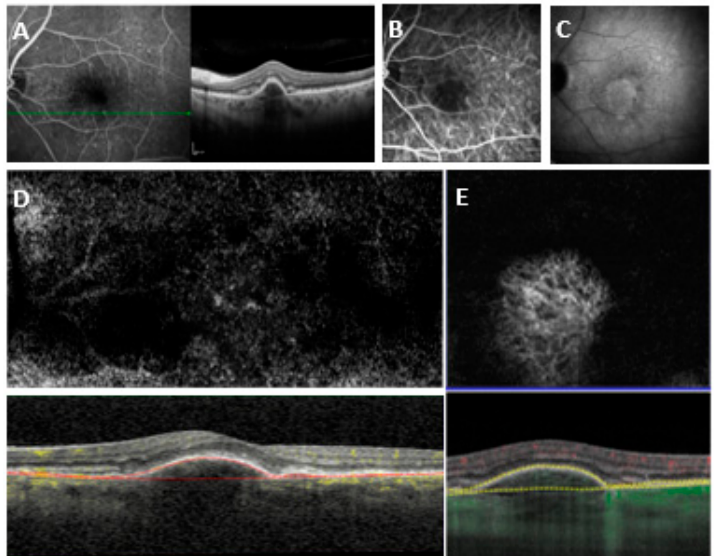
Figure 1. ( A ) SD-OCT crossing through the lesion showing a fibrovascular pigment epithelial detachment (PED) with subretinal fluid. ( B ) Early indocyanine green angiography (ICGA). ( C ) Late ICGA with late hyperfluorescent plaque. ( D ) En face and cross-sectional 3 × 3 mm 2 SD-OCTA with Heidelberg OCT2 RP fit manual segmentation showing no detectable flow. ( E ) En face and cross-sectional 3 × 3 mm 2 SS-OCTA with PlexElite RPE-fit manual segmentation showing a distinct high flow network.